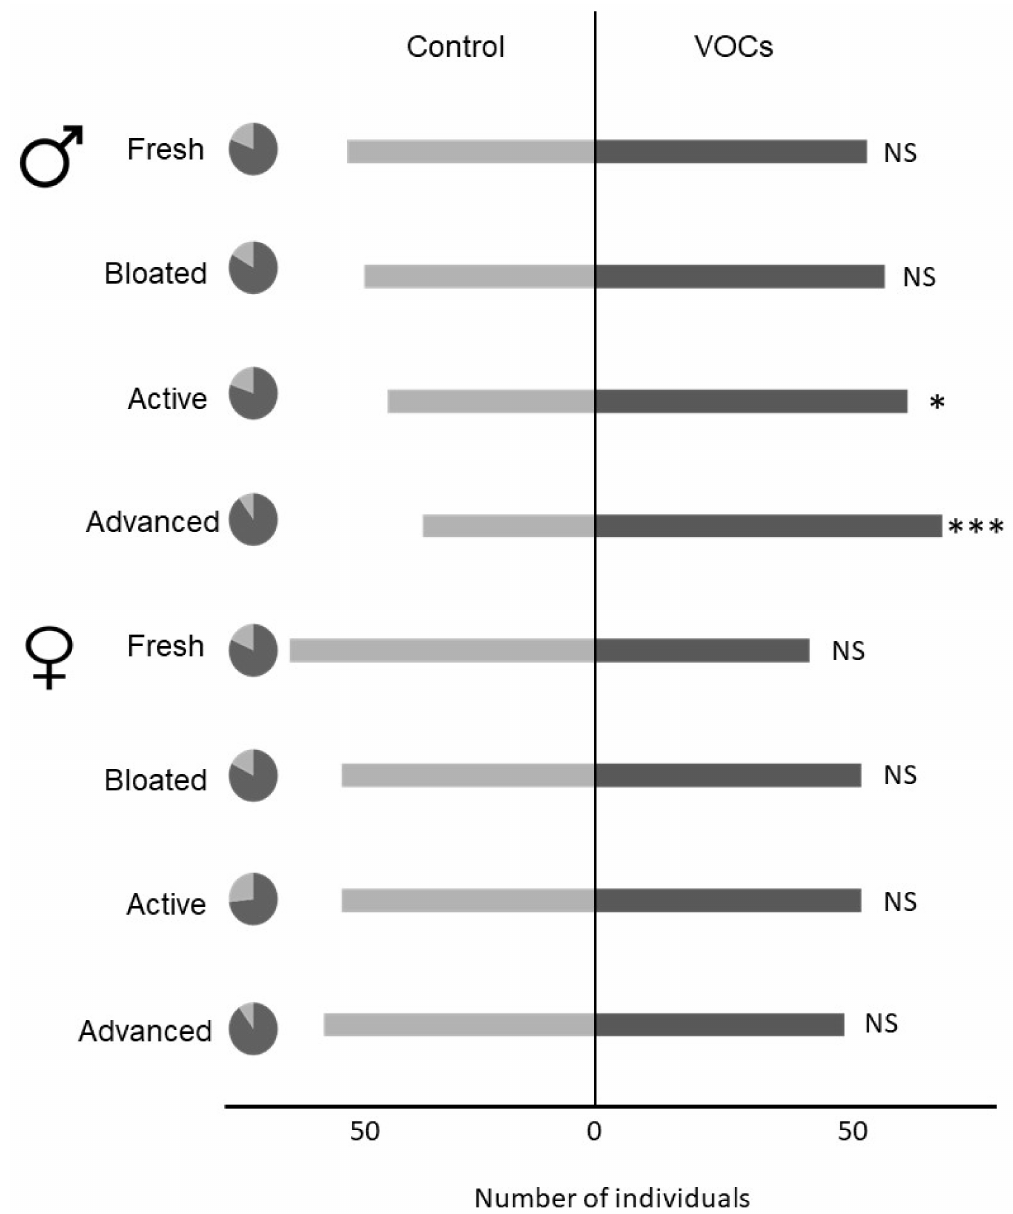
Figure 4. Female and male behavioral responses to the volatile cues associated with each decomposition stage. Dark grey areas in pie charts display proportions of responding individuals. *** p < 0.001 ; ** p < 0.01 ; * p < 0.05 ; NS Not Significant